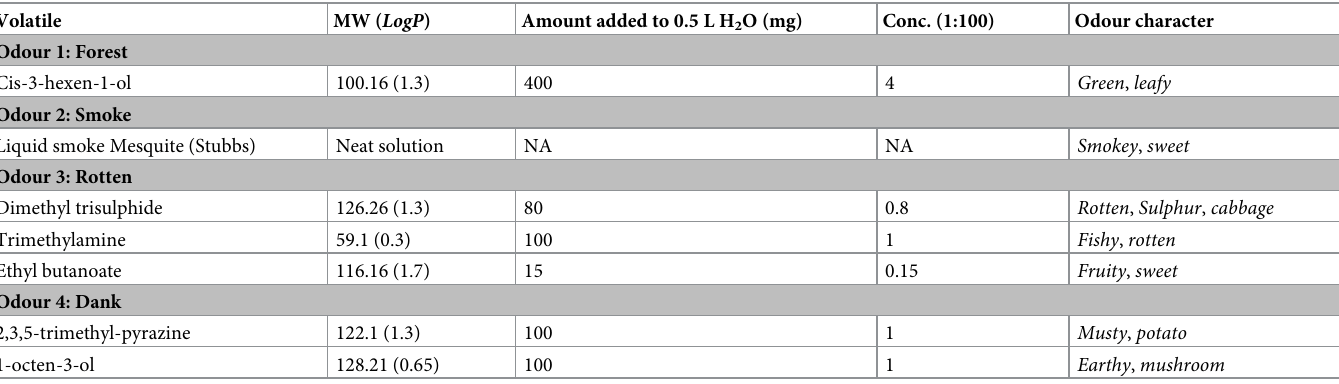
Table 1. Odour solutions prepared for loading into olfactometer.